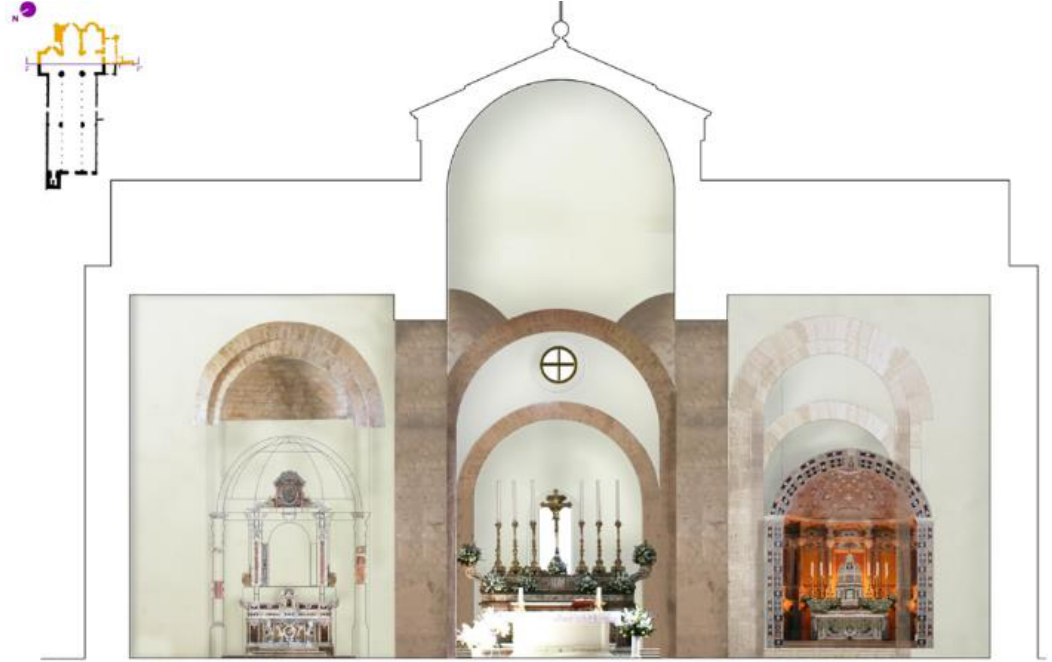
Figure 11. Cross-section of the transept of the cathedral with three